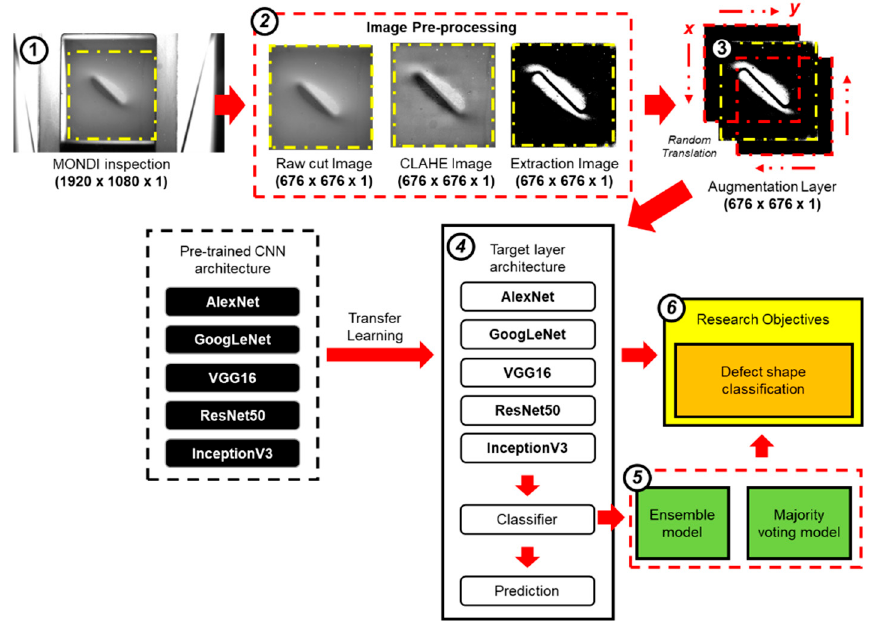
Figure 2. Outline research methodology for magneto-optic nondestructive inspection (MONDI) system with pretrained convolutional neural network (CNN).